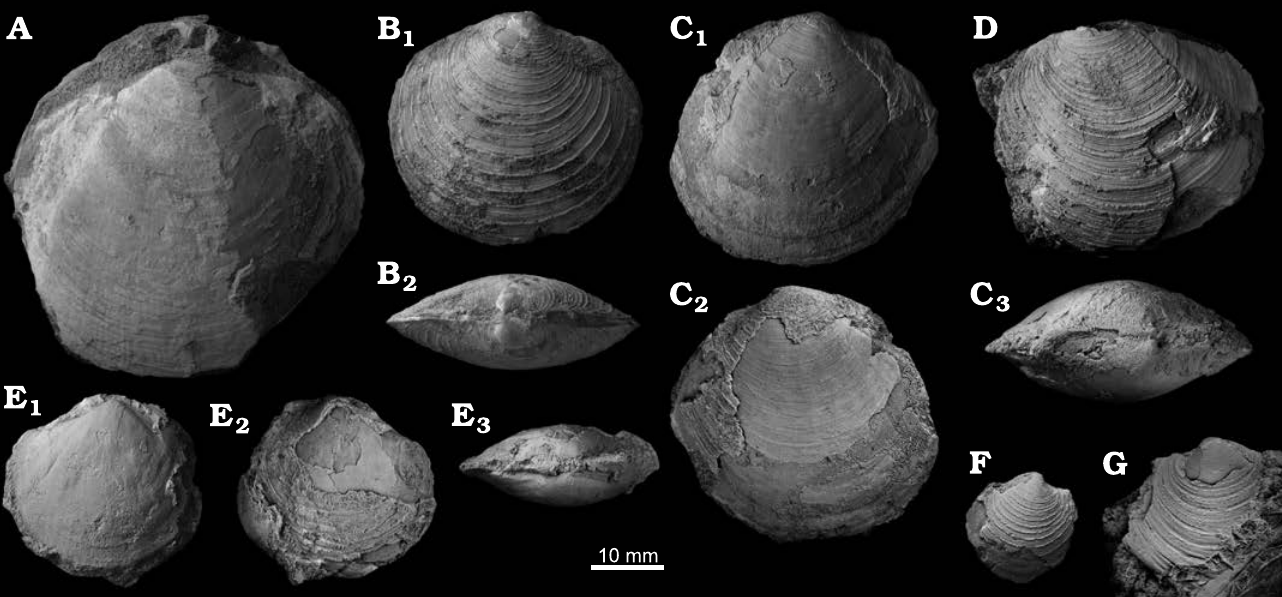
Fig. 9. The lucinid bivalve Lucinoma saetheri Amano, Little, and Campbell, 2018, from Upper Miocene seep deposits of the Amlang Formation in Pangasinan province, Luzon, Philippines. A . NRM Mo 192623, articulated specimen, view RV (A 1 ), LV (A 2 ) and on dorsal side (A 3 ). B . NRM Mo 192624, damaged, articulated specimen, view on LV showing fine concentric ribbing (B 1 ) and on dorsal side showing inflation and ligament (B 2 ). C . NIGSPAL-020, articulated specimen with well-preserved concentric ribs, view on RV (C 1 ) and on dorsal side (C 2 ). D . NRM Mo 192625, small artic- ulated specimen, view on LV (D 1 ) and on dorsal side (D 2 ).